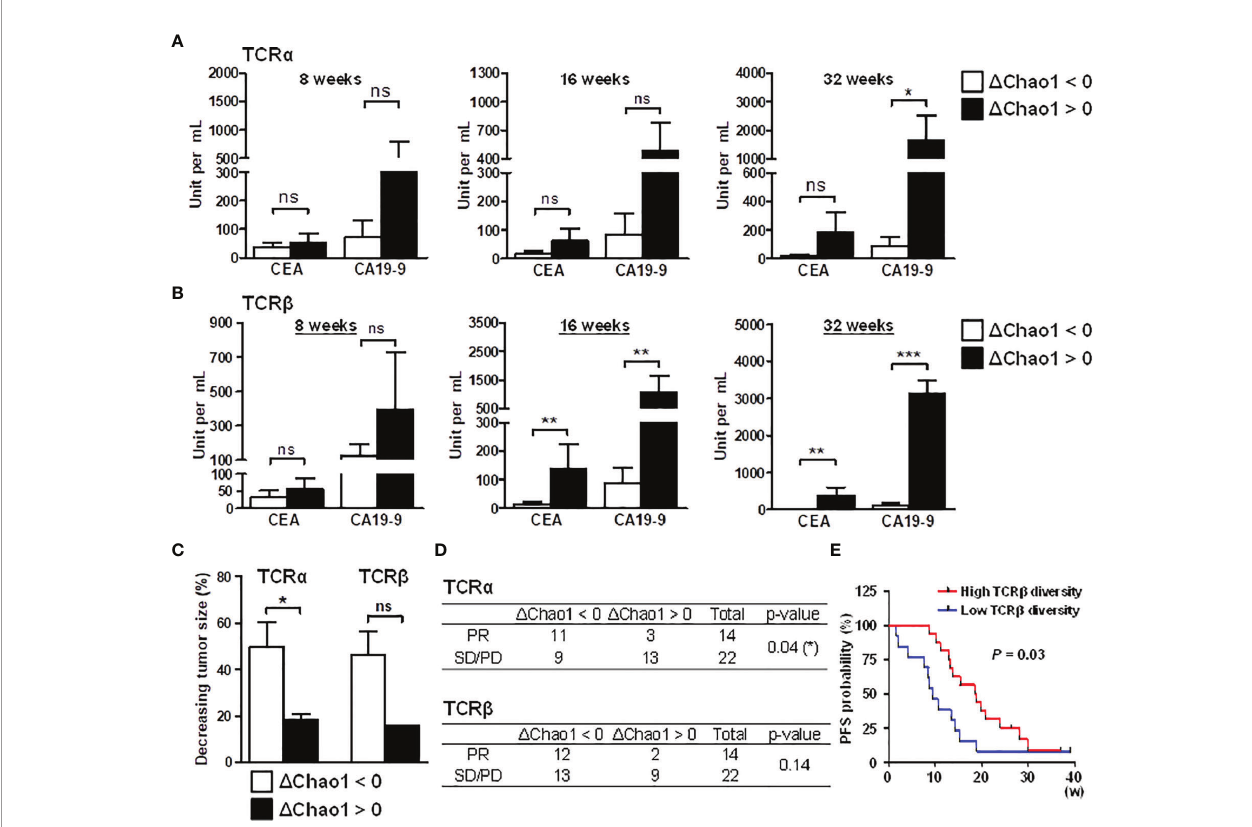
FIGURE 5 | Association between decreased TCR repertoire diversity and prognosis in CRC patients. Compared to the baseline Chao1 index, patients with a decreased Chao1 index during chemotherapy were categorized into the diversity decreasing group ( D Chao1 < 0); patients with an increased Chao1 index during chemotherapy were considered the diversity increasing group ( D Chao1 > 0). To determine the association between TCR and diagnosis, TCR a (A) and TCR b repertoire (B) diversity, the differences in CEA and CA19-9 levels were analyzed between the D Chao1 > 0 and D Chao1 < 0 groups at the indicated time points of 8 weeks, 16 weeks, and 32 weeks after therapy. Statistical signi fi cance was determined using Mann-Whitney U test method. (C) The association between the dynamics of the Chao1 index and tumor size was analyzed. The Chao1 deviation at 16 weeks after therapy compared to baseline diversity was categorized into diversity decreasing group ( D Chao1 < 0) or diversity increasing group ( D Chao1 > 0). The percentage of decreased tumor size at 16 weeks was calculated by normalizing to the corresponding tumor size of CRC-pre subjects. Statistical signi fi cance was determined using Mann-Whitney U test method. (D) The association between TCR a and TCR b Chao1 deviation in treatment response, including partial response (PR), stable disease (SD) and progressive disease (PD), was analyzed using Pearson ’ s chi-square test. A statistical p-value lower than 0.05 was noted. (E) The association between baseline TCR b diversity and PFS was assessed, and the obtained P -value is shown. ns p > 0.05, *p < 0.05, **p < 0.01, ***p <